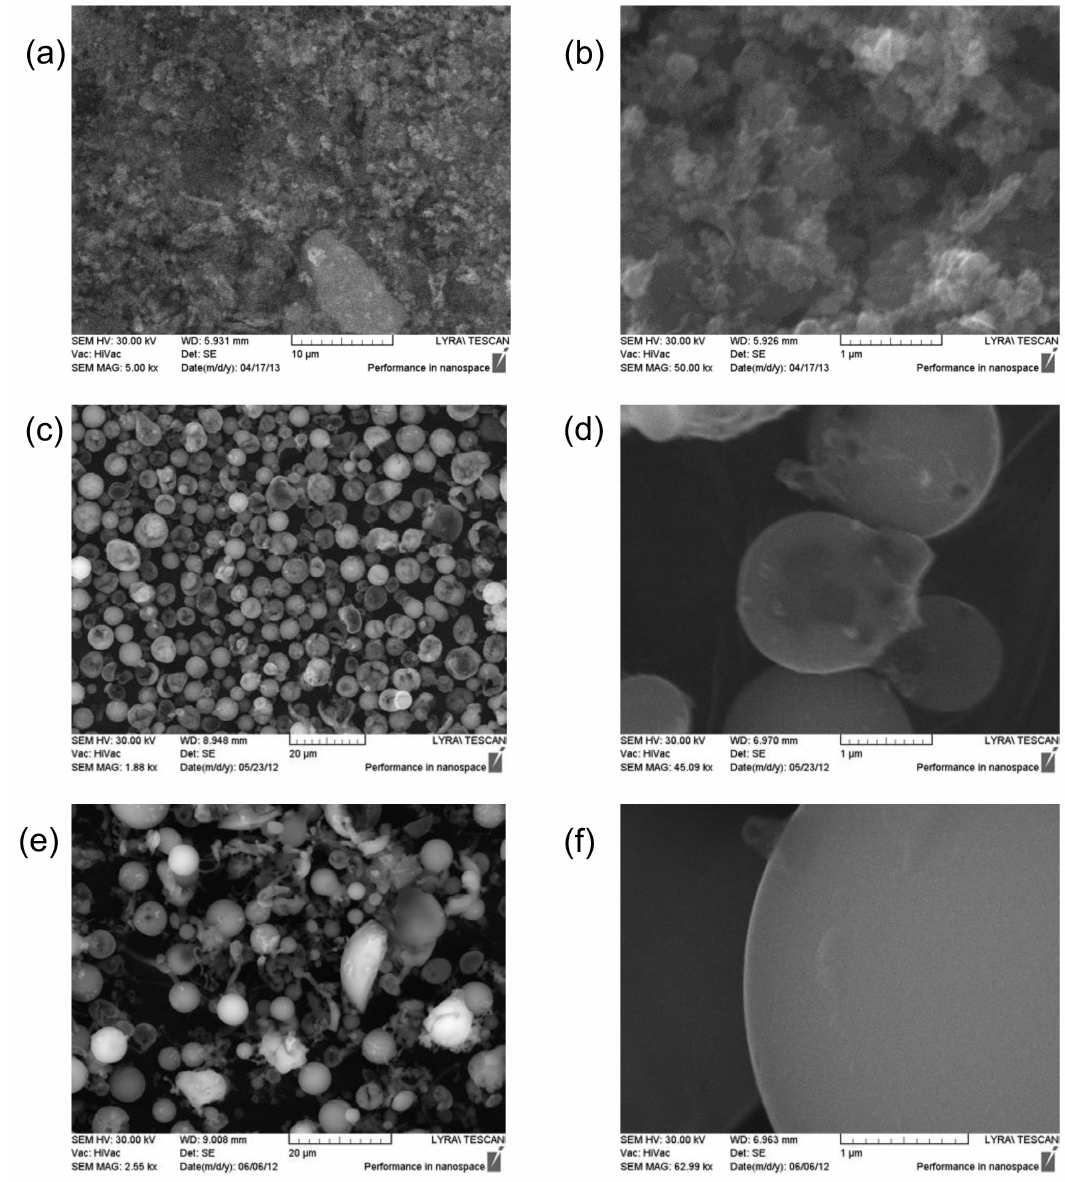
Figure 3. SEM images of particle aggregates obtained at precursor concentration of 1.37 M TiCl 4 and oily phase containing ( a , b ) 0.1 wt % Span 80, ( c , d ) 1 wt % Span 80, or ( e , f ) 3 wt % Span 80 dissolved in